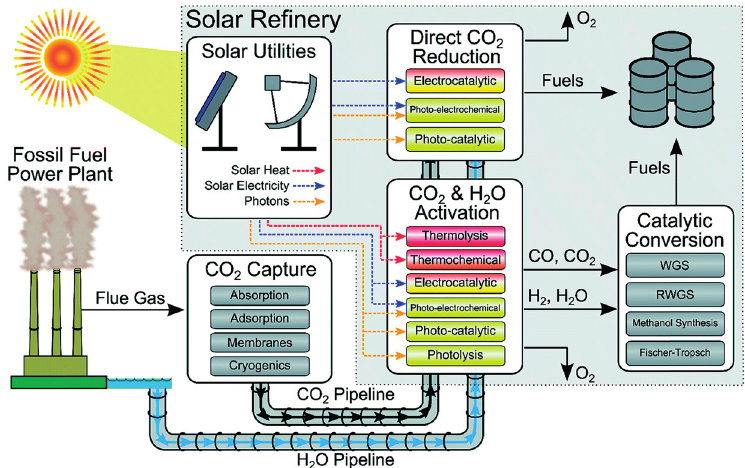
Figure 30. Scheme of a solar refinery based on CO 2 reduction to methanol indirectly by renewable H 2 (ex solar photon- or heat-driven electrolysis) or directly (“one pot”) with H 2 O using solar-electricity (PEC) or solar photons (photocatalysis) (reproduced from [231] with permission of the Royal Society of